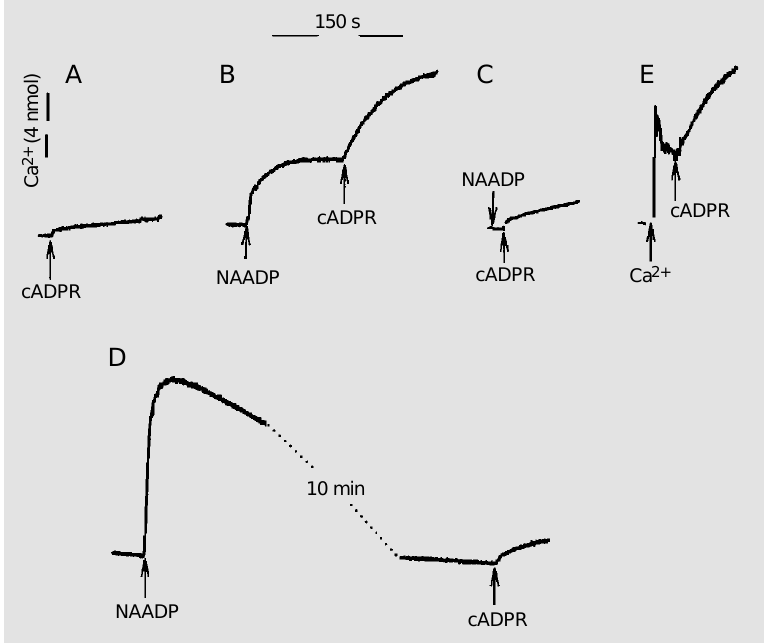
Figure 3. Potentiation of the cyclic ADP-ribose (cADPR)-induced Ca 2+ release by Ca 2+ released from the nicotinic acid adenine dinucleotide phosphate (NAADP) pool. Free Ca 2+ concentrations were measured as described in Material and Methods using fluo-3. The arrow indicates the sequential addition of different Ca 2+ channel agonists. In A the arrow indicates the addition of 16 nM cADPR that by itself does not promote Ca 2+ release. In B the homogenate was first treated with 12 nM NAADP and 16 nM cADPR was added at the peak (steady state) of the Ca 2+ release induced by NAADP. In C the homogenate was pretreated with 2 nM NAADP for 20 min (not shown) to promote self-desensitization of the NAADP receptor. After that the homogenate was treated with 12 nM NAADP and 16 nM cADPR. In D homogenates were treated with a saturating concentration of 60 nM NAADP and then, after the Ca 2+ released by NAADP was taken up again, the homogenate was treated with 16 nM cADPR. In E the homogenate was treated with 4 nmol Ca 2+ prior to the addition of 16 nM cADPR. The data are representative of 12 different experiments done with three different preparations of sea urchin egg